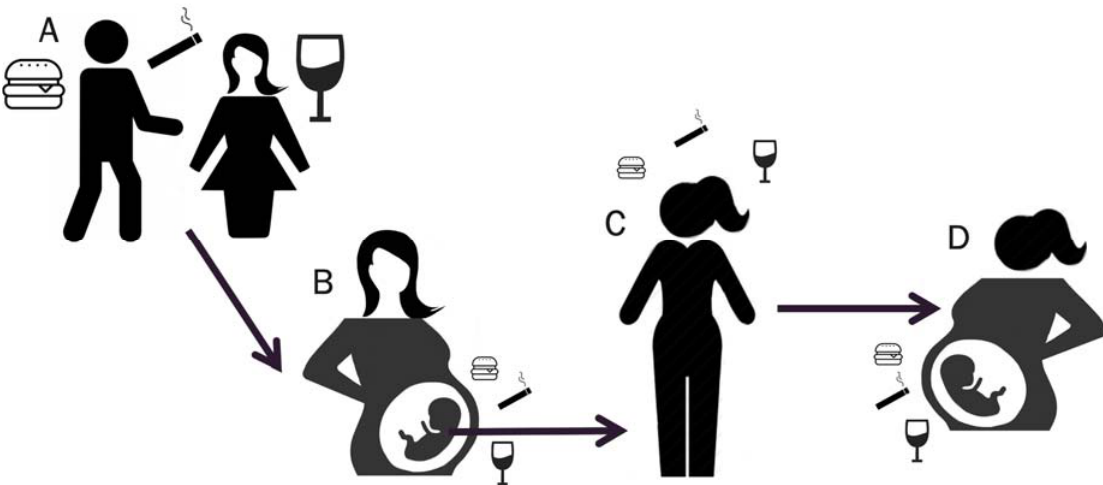
Figure 1. Conceptual model for inherited epigenetic susceptibility to disease. Disease risk in a woman ( C ) may be affected by not only her own lifestyle and environmental exposures but also by what she was exposed to through her mother in utero ( B ) and even through both parents’ pre-conception via exposure-mediated epigenetic changes in their germ cells ( A ). Likewise, the woman’s exposures may a ff ect her future child’s disease risk ( D